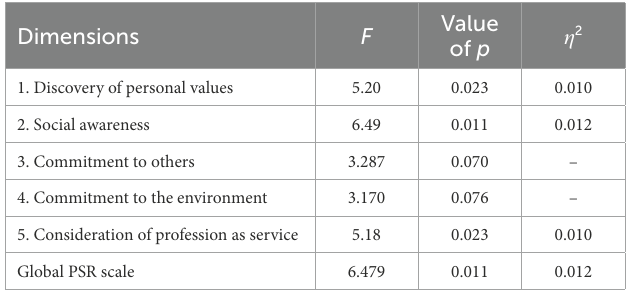
TABLE 5 Gender differences in the factorial ANOVA test